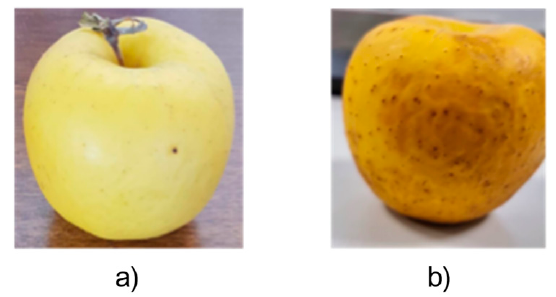
Figure 2. Color of a Golden Delicious apple at week one ( a ) and week six ( b ). For quantitatively evaluating color changes in apple skin during storage, L*, a*, and b* are plotted in Figures